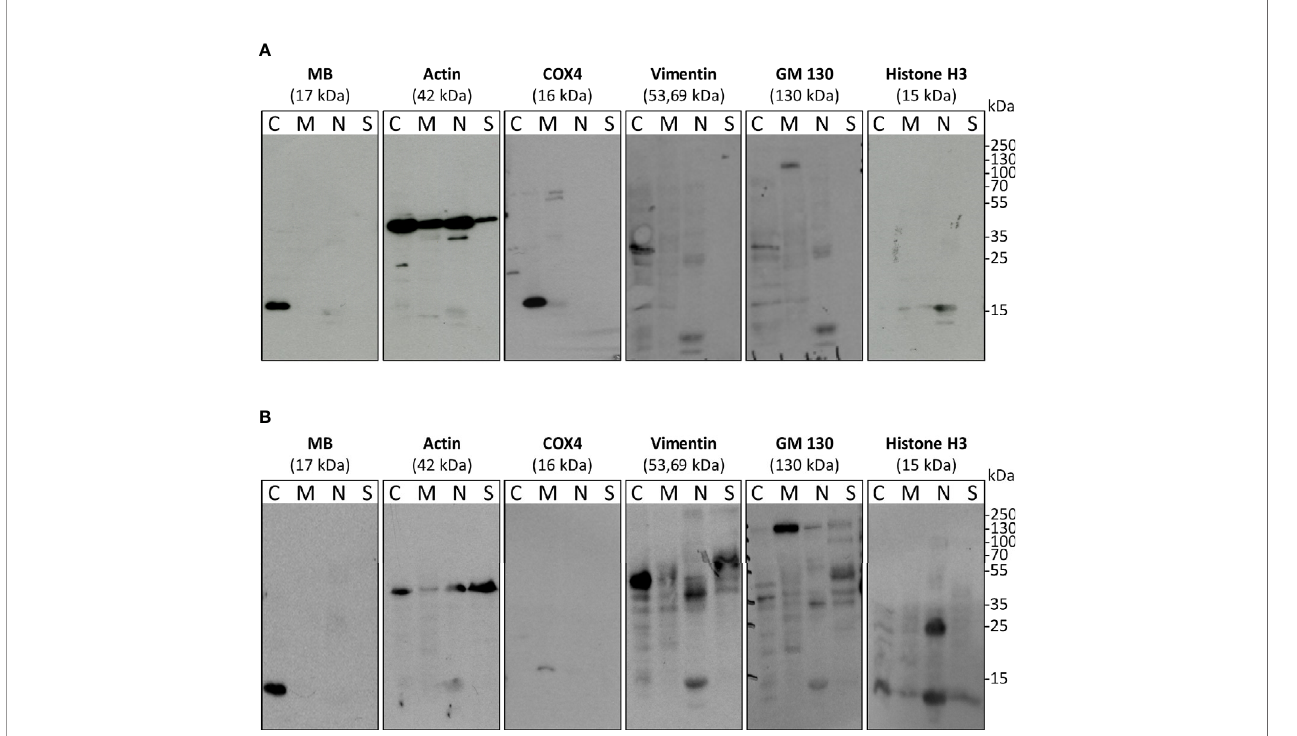
FIGURE 1 | Subcellular fractionation and Western blots with antibodies against myoglobin (MB) and cell compartment-speci fi c marker proteins (histone H3 – nucleus, actin – abundant, Cox4 – mitochondria, Vimentin – cytoplasm and cytoskeleton, GM130 – membrane. MDA-MB-468 cells were cultured under normoxia (A) or 1% O 2 (=hypoxia) (B) for 72 h. Fractions include: C, cytoplasm; M, membrane and mitochondria; N, nucleus; S,